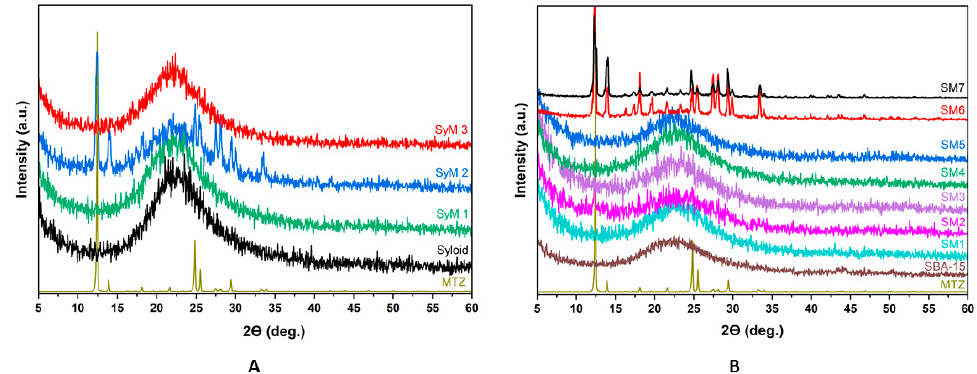
Figure 6. X-ray diffractograms of metronidazole–MSM particles (( A ): Syloid, ( B ): SBA-15).